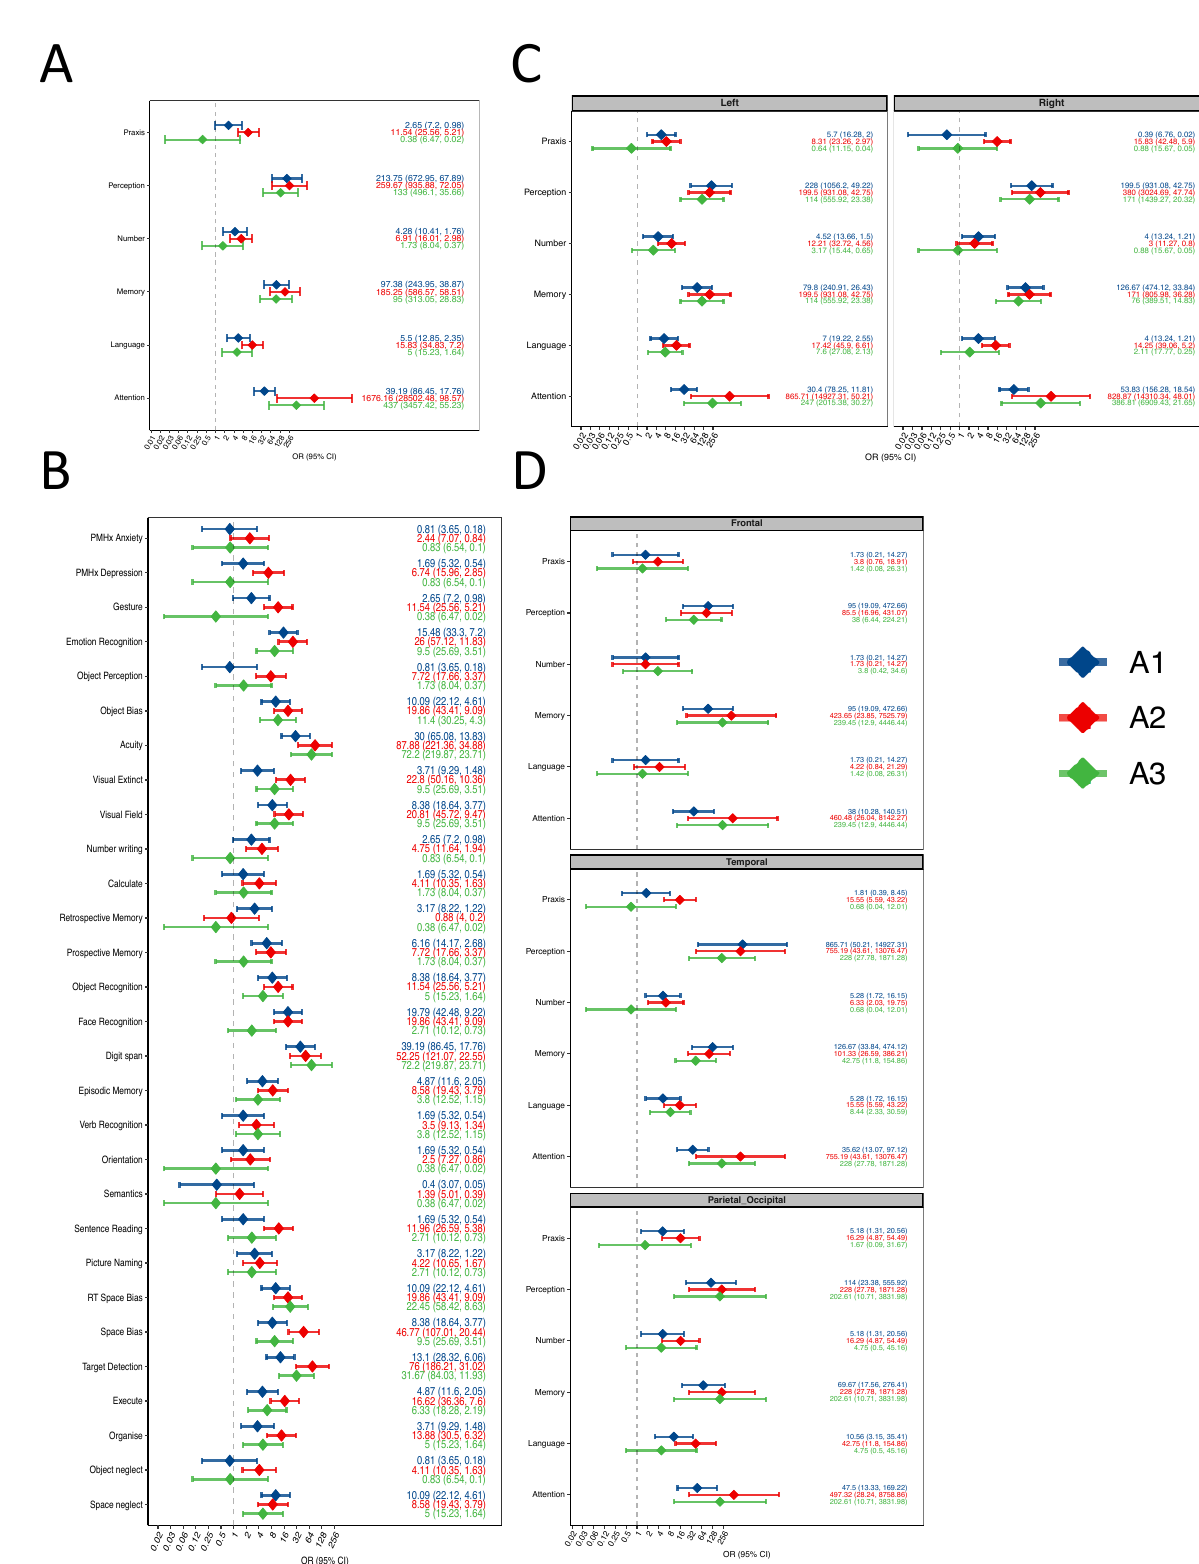
Figure 3. Risk of cognitive deficit at A1, A2, and A3. ( A ) Forest plot displaying the OR of cognitive deficit at A1, A2, and A3, relative to healthy control risk (dotted line), for each cognitive